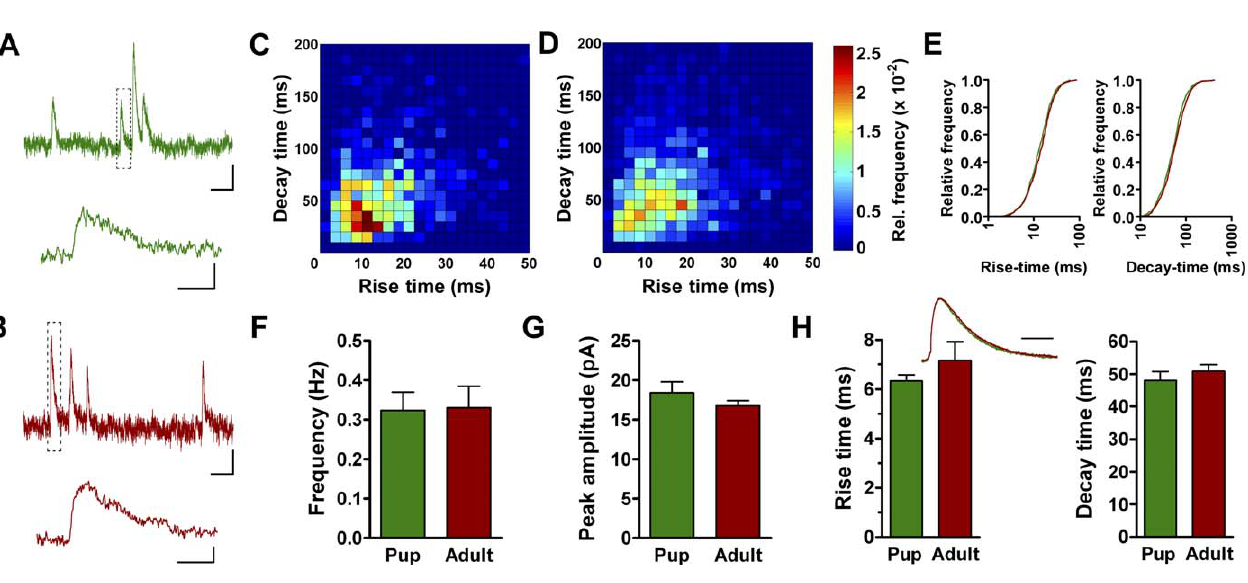
Figure 7. Slow-Dendritic sIPSCs (A) and (B) Example of traces of outward sIPSCs recorded from a pup (A) and adult (B) DGC. Dashed box on each top trace denotes expanded segment on the bottom. Scales indicate 0.5 s/50 ms (top/bottom), 10 pA. (C) and (D) Two-dimensional histograms of rise and decay time of individual sIPSCs recorded from pup ([C] n ¼ 695 events) and adult DGCs ([D] n ¼ 1,160 events). Color scale indicates the relative frequency for each bin. (E) Cumulative histograms of rise and decay time of all sIPSCs recorded from pup (green) and adult DGCs (red). Same data as shown in (C) and (D). (F) Frequency of sIPSCs (pup, n ¼ 10 neurons; adult, n ¼ 16; p ¼ 0.94; t -test). (G) Peak amplitude of sIPSCs (pup, n ¼ 10; adult, n ¼ 14; p ¼ 0.44). (H) Kinetics of sIPSCs. Inset: scaled averages of sIPSCs (pup, green; adult, red). Scale bar indicates 50 ms. All experiments conducted in the presence of kyn at V hold ¼ 0 mV with an internal solution containing high [Cl (cid:2) ]. ( n , same as in [F]; rise time, p ¼ 0.37; decay time, p ¼ 0.41). DOI: